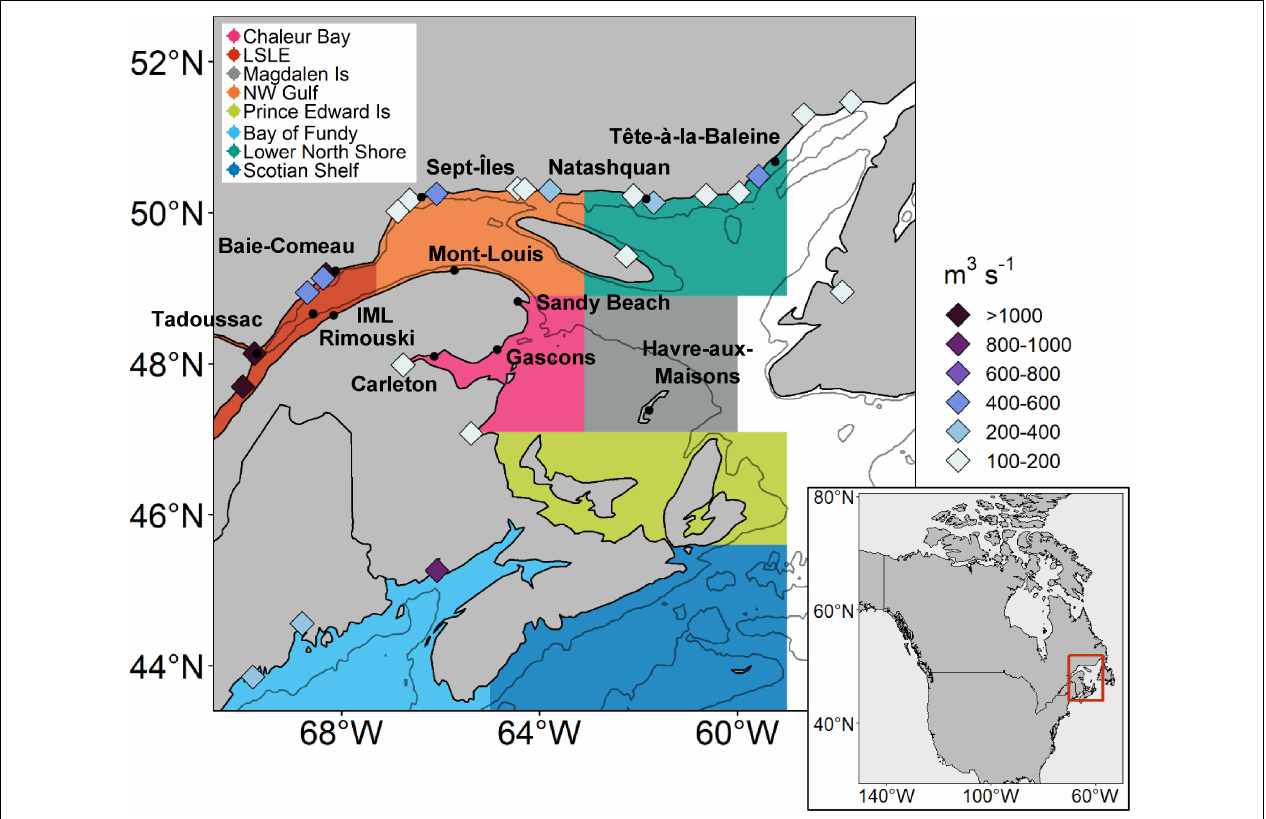
FIGURE 1 | Map of the Atlantic coast of Canada. Names of harmful algae sampling stations are in bold and their locations are indicated by black dots. Extent of the regional boxes are defined by colored polygons. Hundred meter bathymetry is indicated by gray contour lines. Main rivers (with average discharge > 100 m 3 s − 1 ) and their average discharge between 1999 and 2008 are indicated by